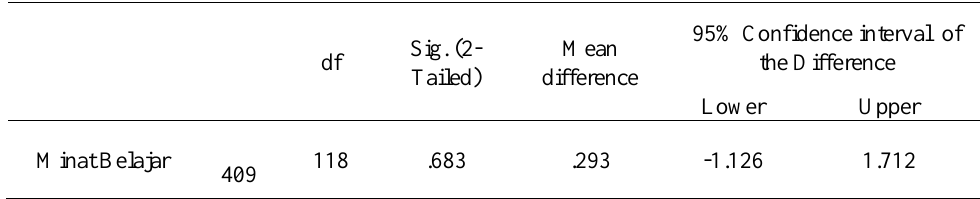
Tabel 4. Hasil Uji